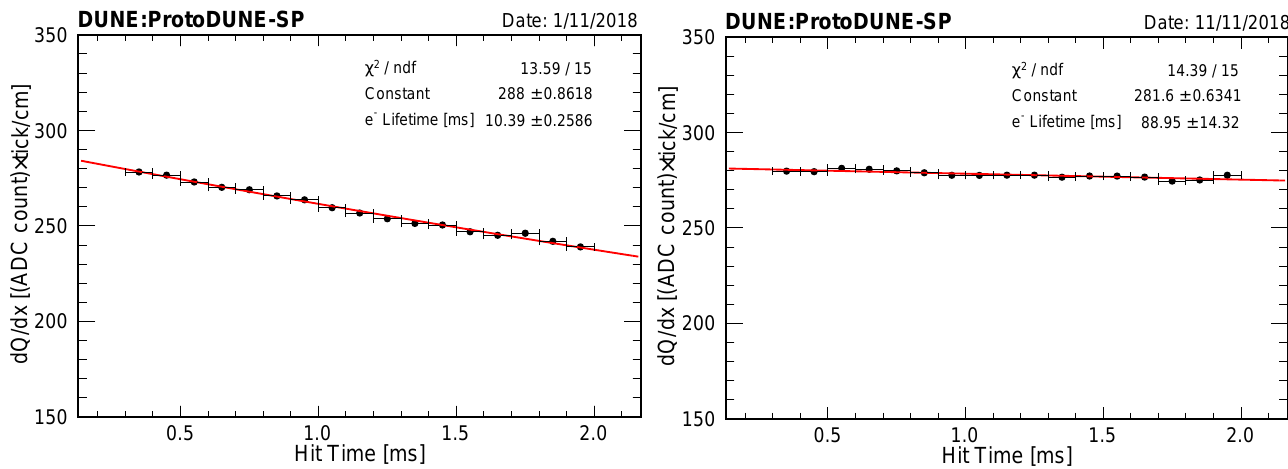
Figure 7. Plot of the most probable value of the dQ / dx distribution in ProtoDUNE as a function of the hit time, fit to an exponential decay function during a period of lower purity ( left : τ e = 10.4 ms) and during a period of higher purity ( right : τ e = 89 ms). This figure is from